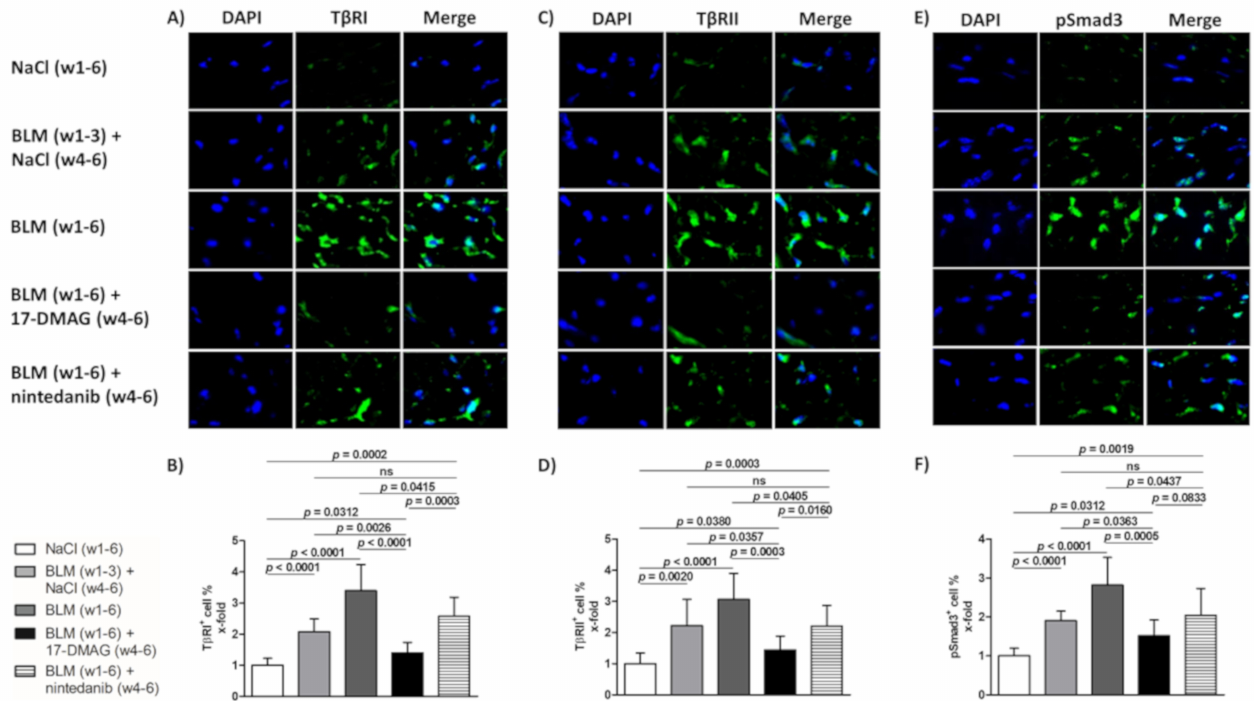
Figure 5. Treatment with 17-DMAG inhibits the TGF- β /Smad signaling induced by bleomycin. Representative images of T β RI- ( A ), T β RII- ( C ), and phosphorylated Smad3 (pSmad3)-stained skin sections are shown ( E ). T β RI-, T β RII-, and pSmad3-positive cells are stained green, and nuclei are stained blue by DAPI. Original magnification × 400. Treatment with 17-DMAG decreased the accumulation of T β RI- ( B ), T β RII- ( D ), and pSmad3 ( F ) induced by bleomycin. Columns represent the mean and whiskers represent the standard error of the mean. w, week; NaCl, sodium chloride; BLM, bleomycin; 17-DMAG, 17-dimethylaminoethylamino-17-demethoxygeldanamycin (inhibitor of heat shock protein 90); T β RI, TGF- β receptor type I; T β RII, TGF- β receptor type II; ns, not significant ( p ≥ 0.05); n = 8 mice in each